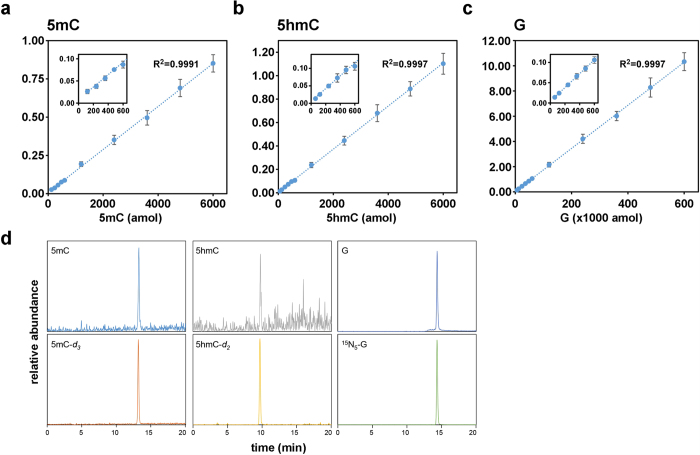
Standard curves of 2′-deoxyguanosine (G), 5-methyl-2′deoxycytidine (5 mC) and 5-hydroxymethyl-2′-deoxycytidine (5 hmC).Standard curves for (a) 5 mC, (b) 5 hmC and (c) G and (d) representative SMM chromatograms. Specific monitoring of target nucleosides was accomplished based on nucleoside-specific fragmentation, which is the loss of deoxyribose-moiety (m/z 116) from each parent ion. Peak area was normalized by dividing net peak area of each target by that of its internal standard. X-axes in (a–c) represent the quantity (amol) of injected nucleoside and Y-axes plot the ratio of each nucleoside to the labelled standard.